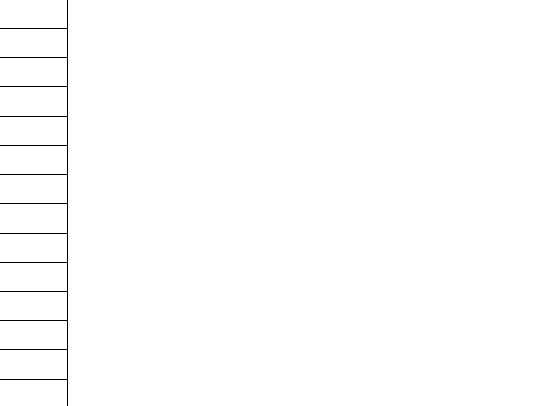
Figure 2. Forest plot showing the pooled prevalence of anencephaly in Africa, 2020. S.